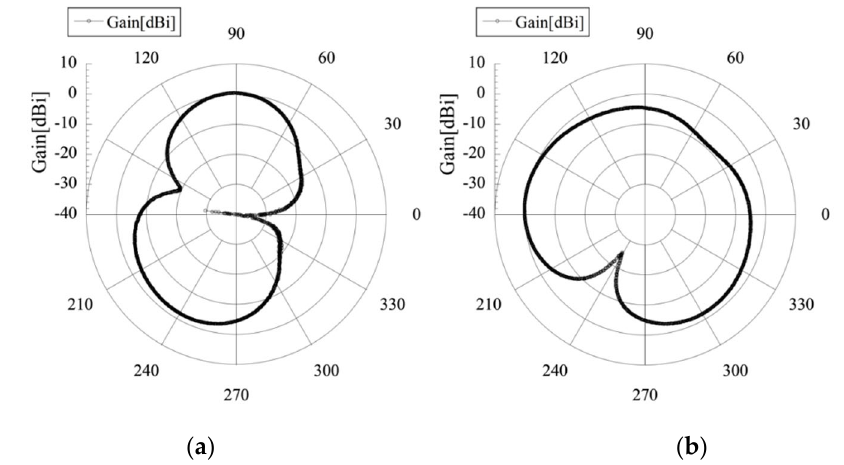
Figure 10. Radiation pattern of the designed monopole antenna for ( a ) 400 MHz and ( b ) 433 MHz.